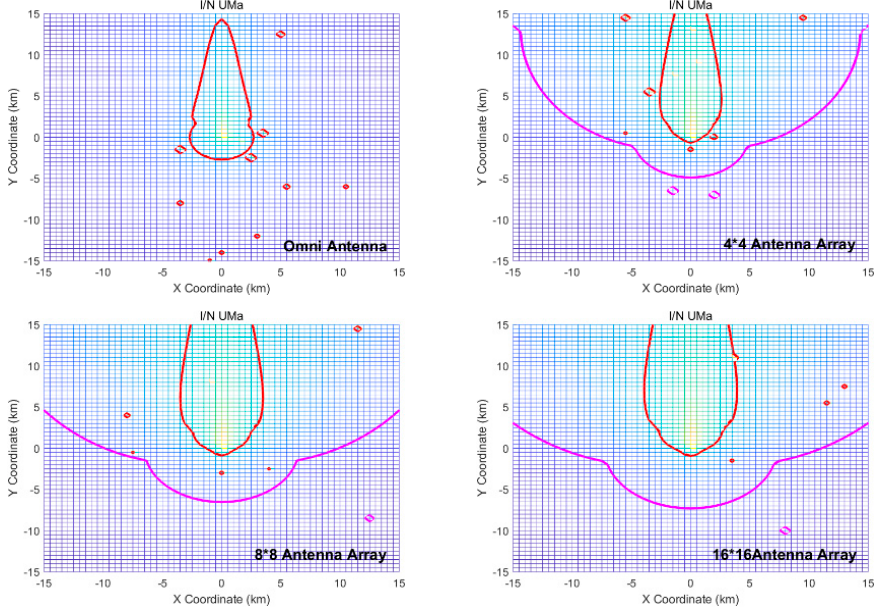
Figure 28. Sizes of exclusion and restriction zones for various UMa scenarios.